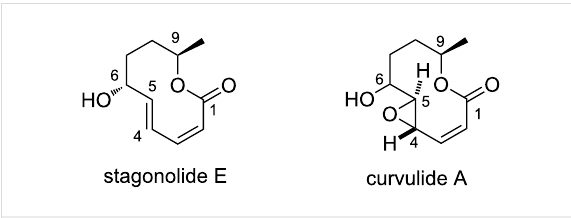
Figure 1: Structures and numbering scheme for stagonolide E and curvulide